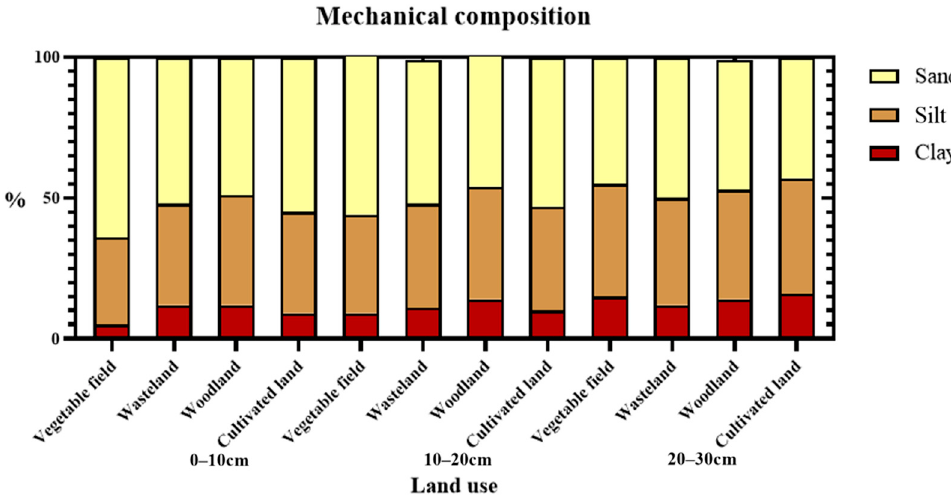
Figure 2. Textures of soils at various depths under different land use types.